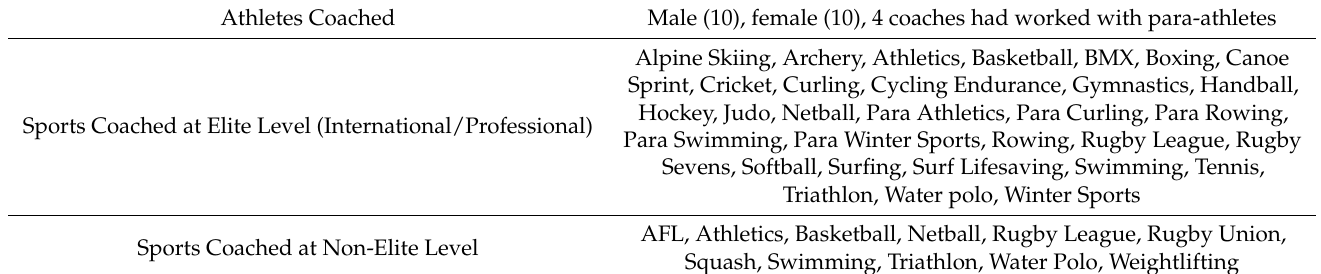
Table 2. Work experience characteristics of HLCs